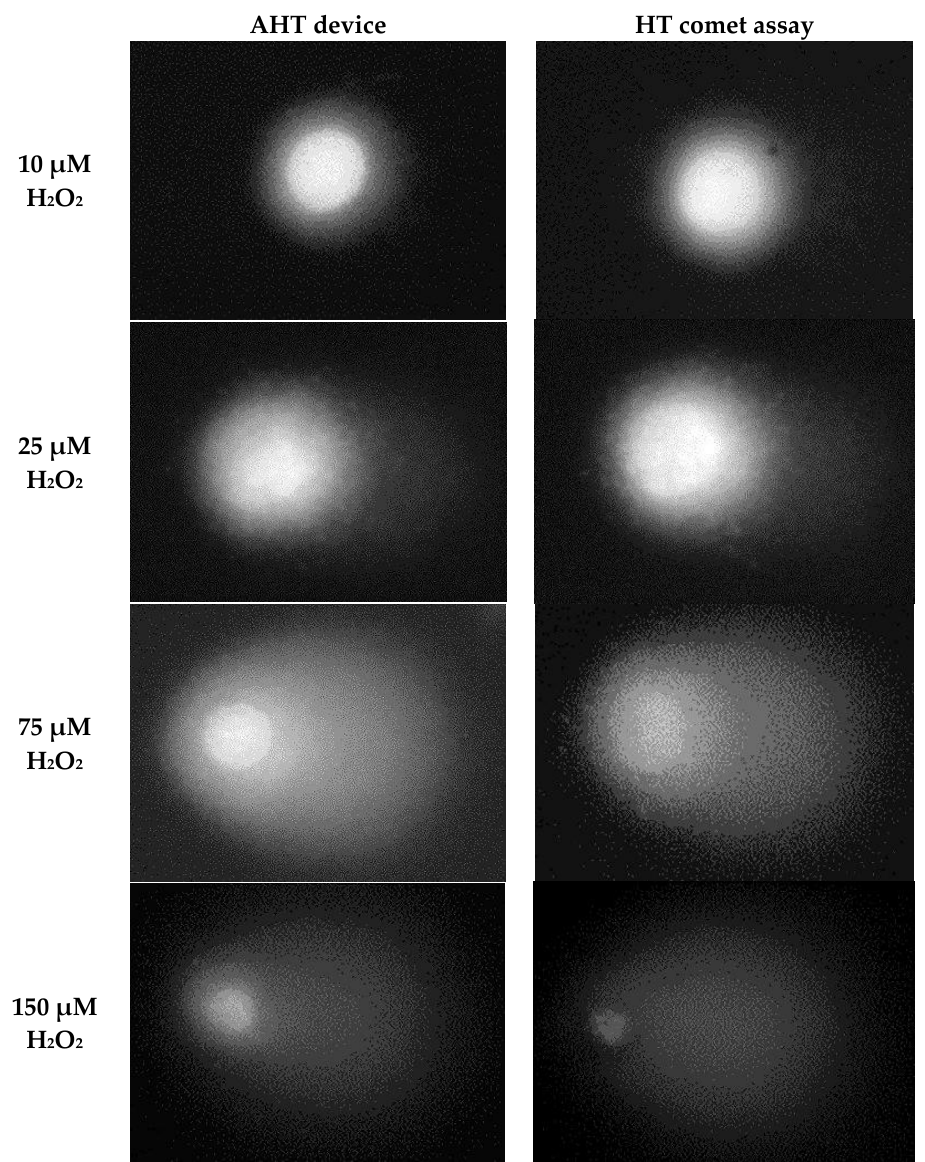
Figure 2. Representative images of comets generated from HaCaTs, which were incubated with 0–150 μM H 2 O 2 prior to analysis by the HT ( right ) or AHT ( left ) approaches. The comet images generated by both assays were entirely comparable to each other in terms of the overall comet shape and regularity.